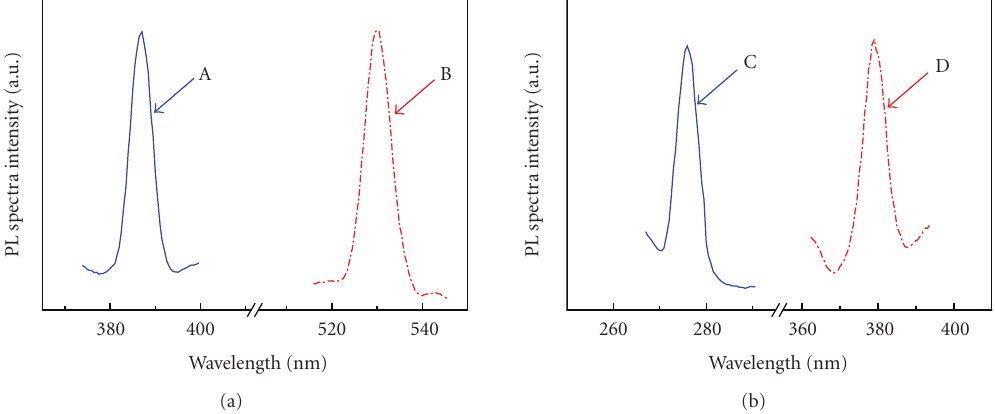
Figure 5: Photoluminescence (PL) spectra of the synthesized La 1 / 3 MO 3 (M = Nb, Ta) powders at 77K: (a) A: an excitation spectrum of La 1 / 3 NbO 3 monitored at 530 nm, B: an emission spectrum of La 1 / 3 NbO 3 excited at 387 nm; (b) C: an excitation spectrum of La 1 / 3 TaO 3 monitored at 379nm, D: an emission spectrum of La 1 / 3 TaO 3 excited at 275